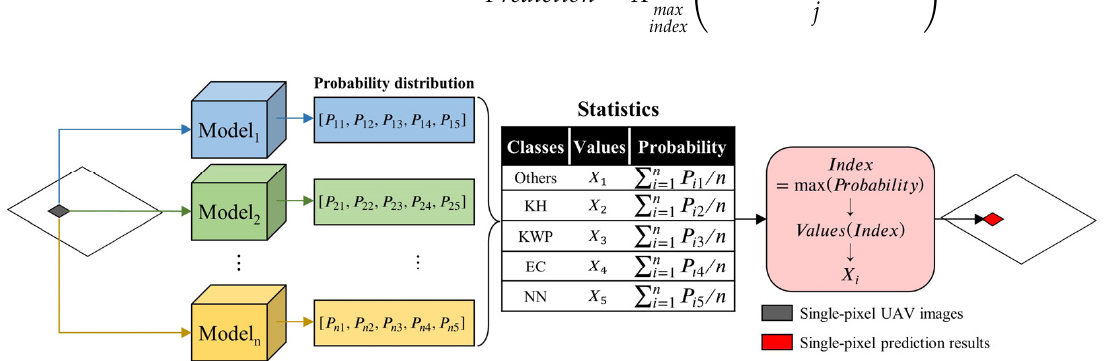
Figure 9. The framework of average probability fusion method.